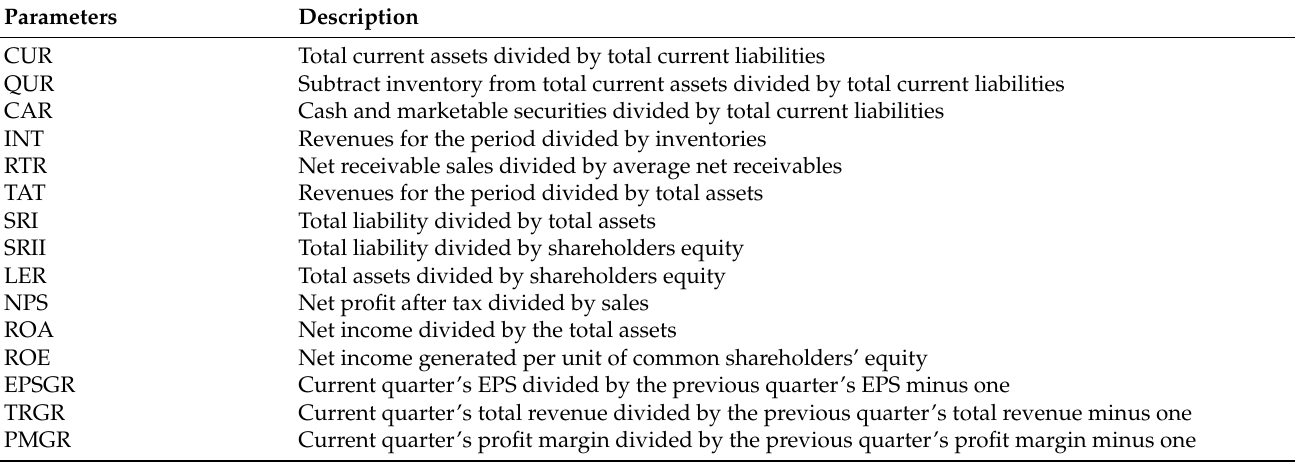
Table 2. The description of all financial indicators in the current study.